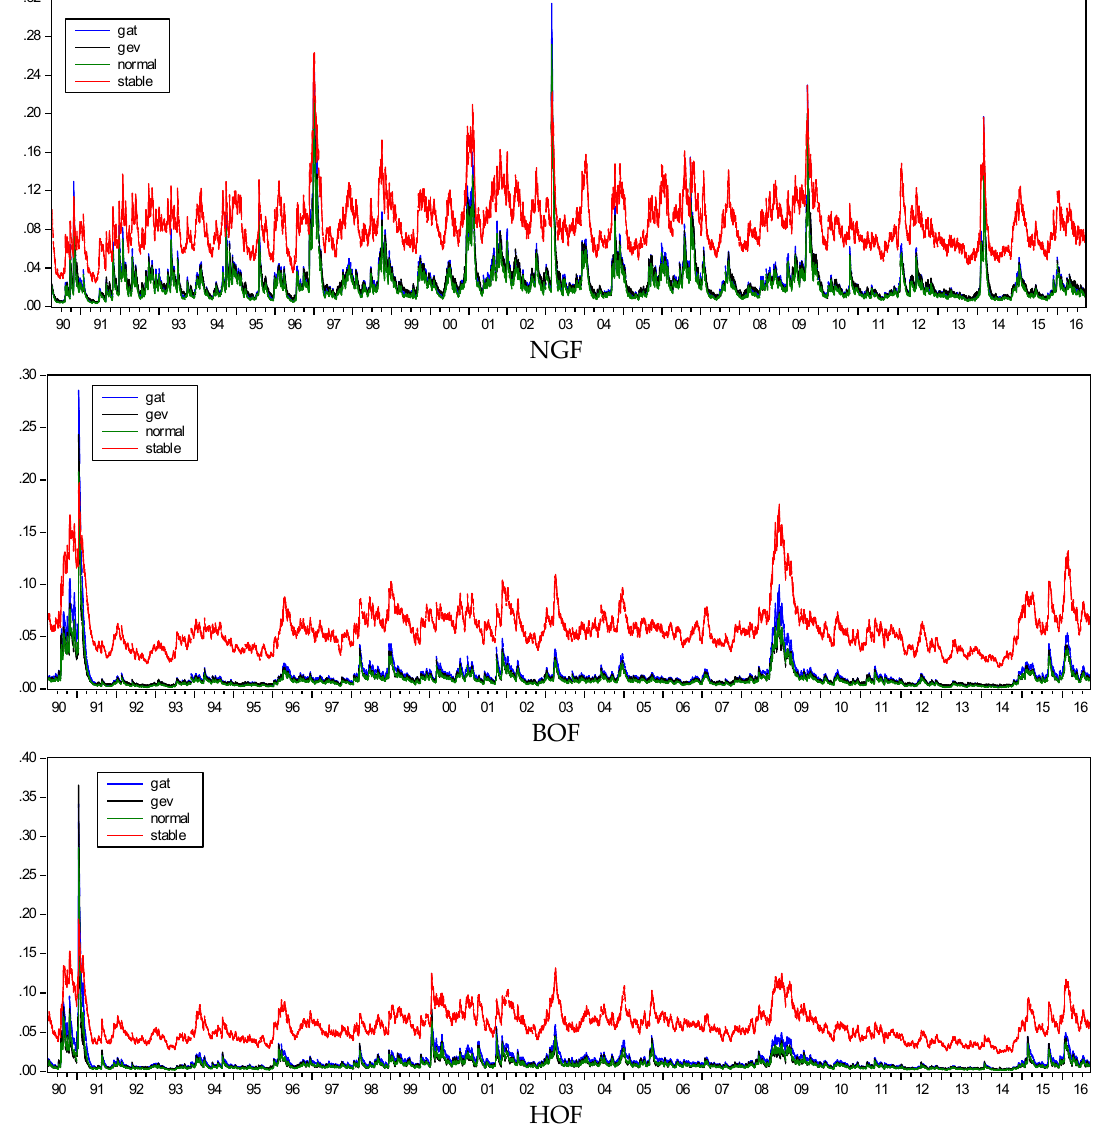
Figure 2. Conditional Volatility of Return Series.